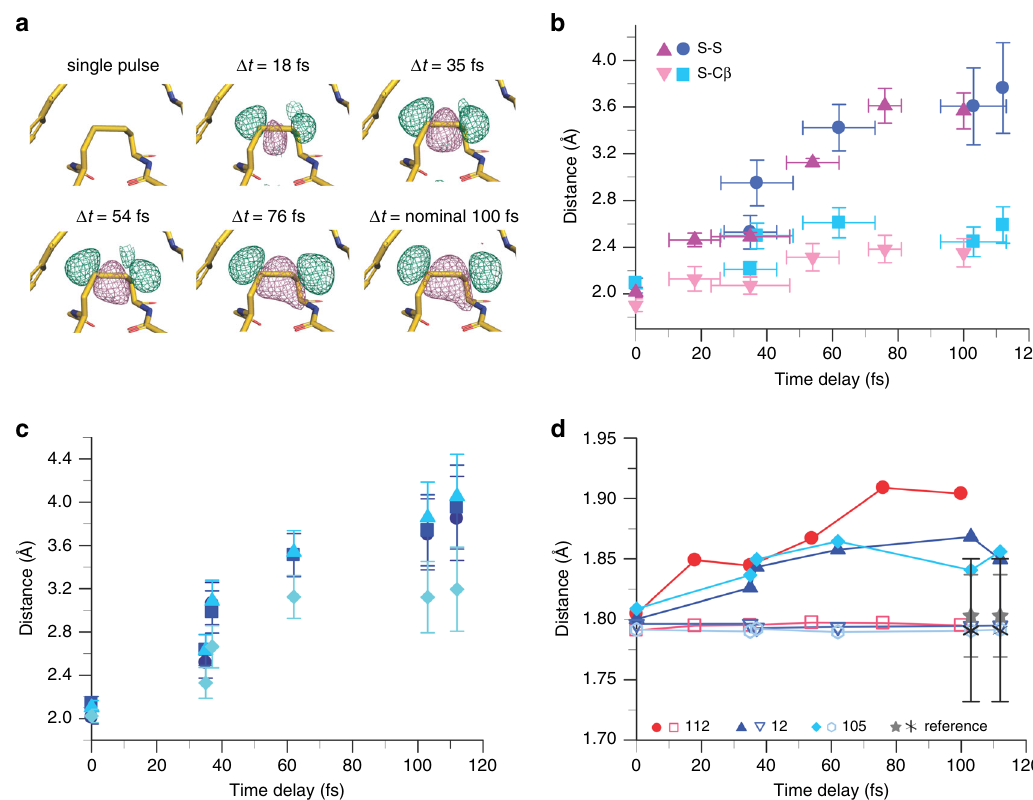
Fig. 1 Disul fi de and thioether bonds. a Isomorphous difference density maps (F obs( Δ t) – F obs(single pulse) ) of thaumatin as a function of pump probe delay show negative (pink) peaks between the exemplarily chosen Cys56 and Cy66 bond and positive (green) peaks on the outside of the bond (contour level ± 3 σ ). This is consistent with an elongation of the S – S bonds. The other disul fi de bonds in thaumatin and lysozyme.Gd show similar effects (Supplementary Figs. 7 and 8). b The average distance of the two sulfurs and the cysteine C β and sulfur S γ in the disul fi de bonds in thaumatin (8 S – S bonds, red symbols) and lysozyme.Gd (4 S – S bonds, blue symbols) increases with the time delay between pump and probe pulse. The error bars ( y -axis) give the standard deviation of the distribution; they do not represent the accuracy of the distance determination. The errors in pump probe delays ( x -axis) are the standard deviations of the XTCAV-derived time-delay values. c The extent of bond elongation and the direction of the movement of the sulfur atoms depends on their local environment (Supplementary Note 2, Supplementary Fig. 10 – 12). In lysozyme.Gd the elongation of the Cys76-Cys94 bond (cyan diamonds) differs from that of the other three S – S bonds (Cys6-Cys127 (blue circles), Cys30-Cys115 (blue squares), Cys64-Cys80 (blue triangles)). The trajectories and local environment of the moving sulfur ions is shown in Supplementary Fig. 11. d Methionine residues. The C γ -S δ bond ( fi lled symbols) in methionine residues lengthens signi fi cantly with pump probe delay in both thaumatin (red) and lysozyme.Gd (blue). The numbers correspond to the sequence number in the protein. The sulfur-C ε -methyl moiety seems to move as an entity given the apparent invariance of the C ε -S bond (open symbols). Reference bond lengths 60 (C γ -S δ ( fi lled gray stars), C ε -S δ (gray stars)) and their standard deviations are shown in